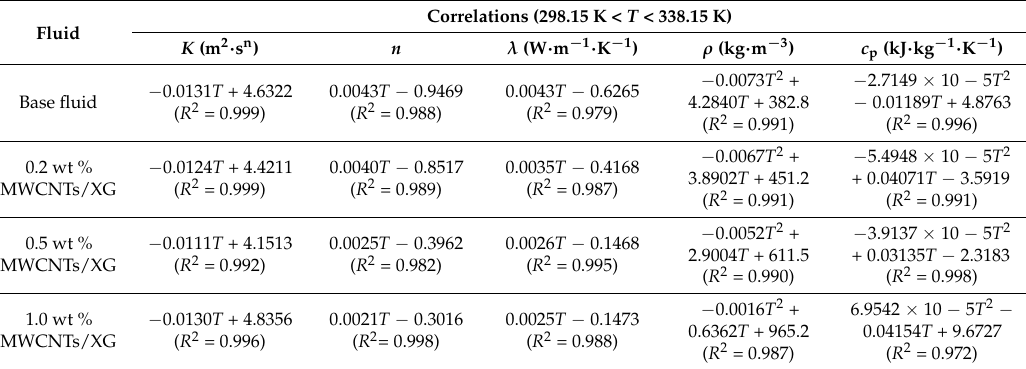
Table 1. Expression of thermal ‐ physical properties.